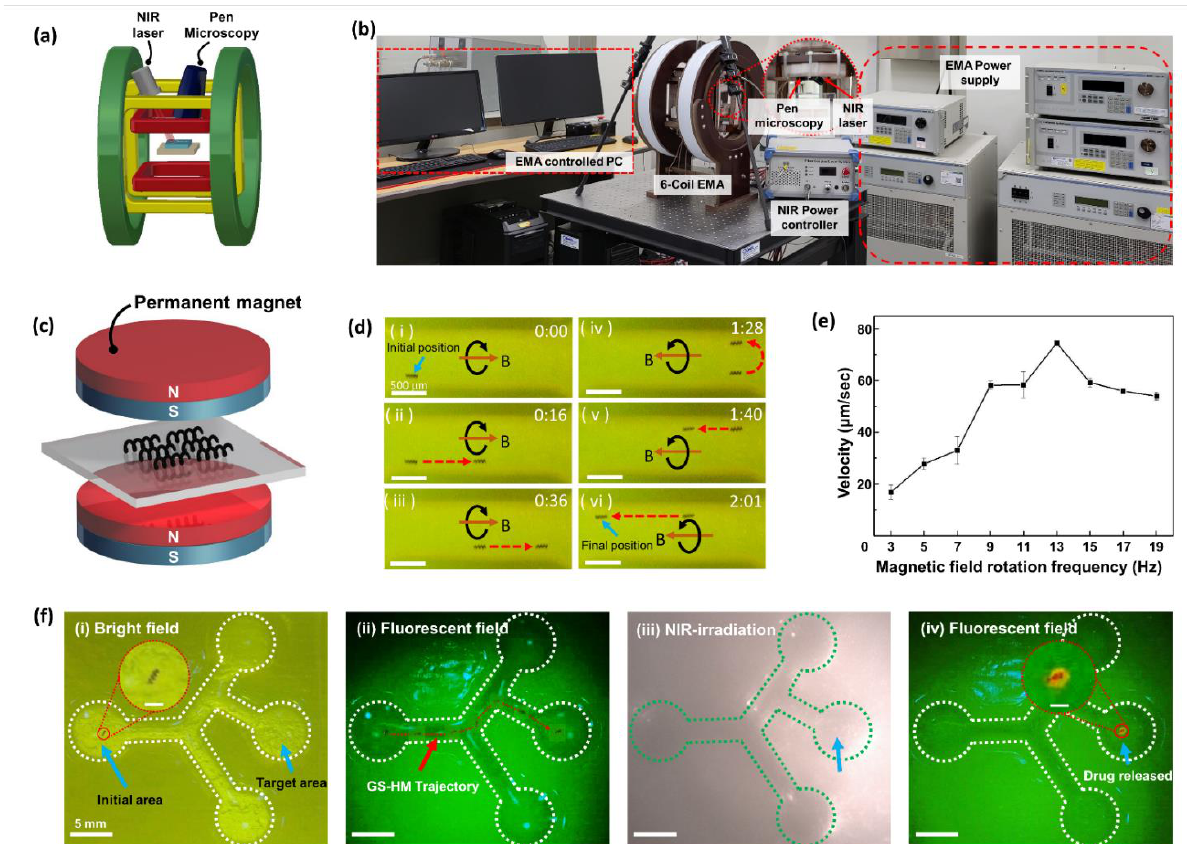
Figure 5. Manipulation and locomotion under an electromagnetic actuation (EMA) system with real-time drug release. ( a ) Schematic illustration of an EMA system, which was set using pen microscopy and an NIR laser. ( b ) Digital photograph of an integrated EMA system targeting delivery and drug release. ( c ) The sample placed between two permanent magnets for the magnetization process to achieve MNP alignment before the locomotion test. ( d ) Locomotion of the GS-HM under external EMA system manipulation: forward ( i – iii ) and backward ( iv – vi ) motions are exhibited. ( e ) The relationship between RMF frequency and velocity; the step-out frequency was 13 Hz. ( f ) Integrating locomotion, including targeting delivery and drug release: the GS-HM starts from the initial area and arrives at the right middle position for the target: ( i ) Drug-loaded GS-HM moved straight, turned left, and turned right once, respectively. ( ii ) The test under a fluorescence field; the red dashed line represents the trajectory. ( iii ) After arriving at the target area, the NIR irradiation is performed for 10 min to completely release the drug. ( iv ) The fluorescence signal releasing drugs around the GS-HM (scale bar in inset figure: 200 µ